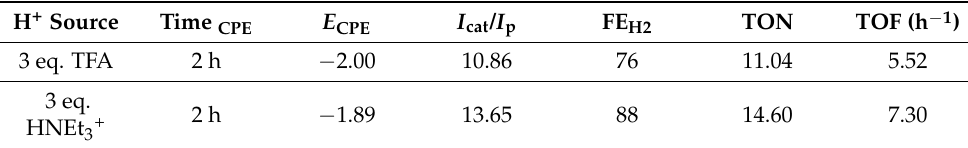
Table 1. Important parameters for the electrocatalytic H 2 evolution a